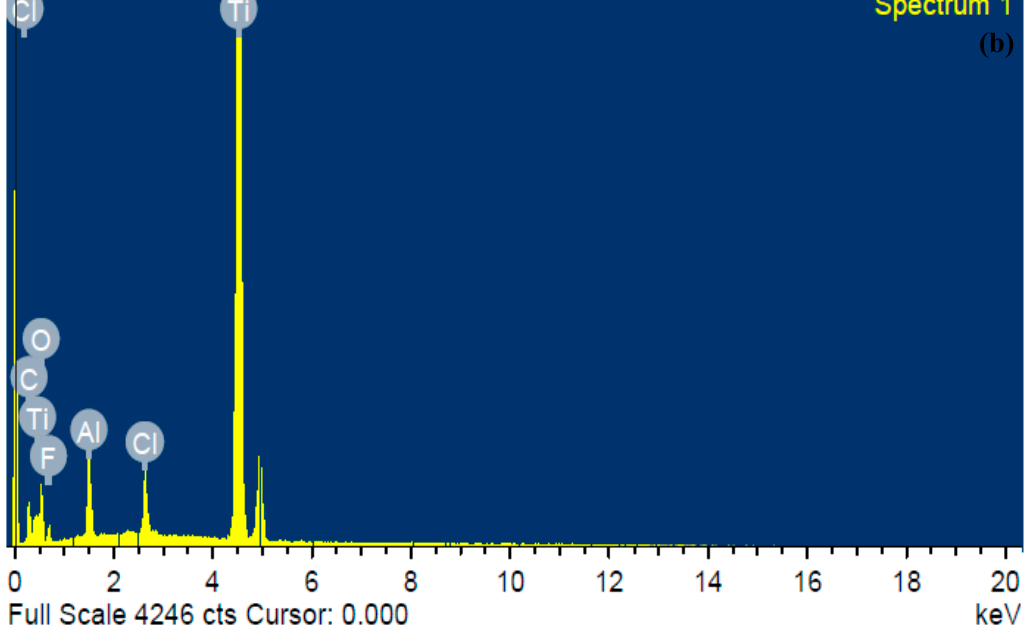
Figure 3. Images of ( a ) Spot at which EDX analysis is performed ( b ) EDX graph of the synthesized MXene.